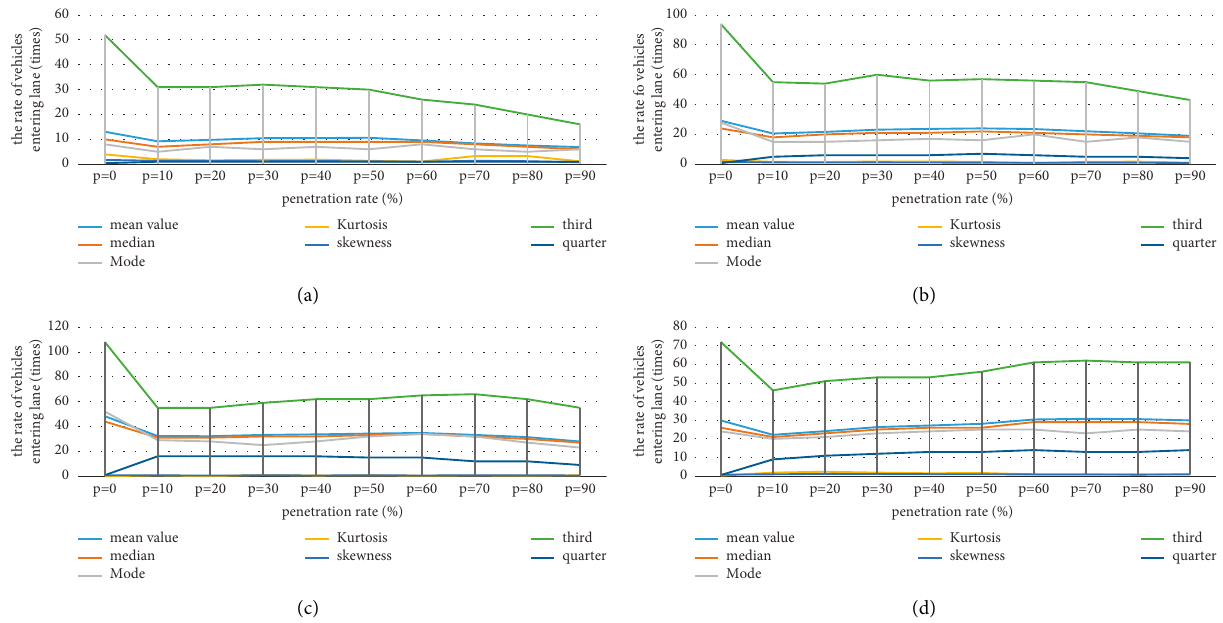
Figure 9: Feature map of the rate of vehicles entering lane under different penetration rate of autonomous driving vehicles. (a) Feature map of the rate of vehicles entering lane in lane 1. (b) Feature map of the rate of vehicles entering lane in lane 2. (c) Feature map of the rate of vehicles entering lane in lane 3. (d) Feature map of the rate of vehicles entering lane in lane 4. Table 1: The liner correlation table of traffic volume q and the rate of vehicles exiting lane (RLC (RLC out ) under different operation ratios of autonomous